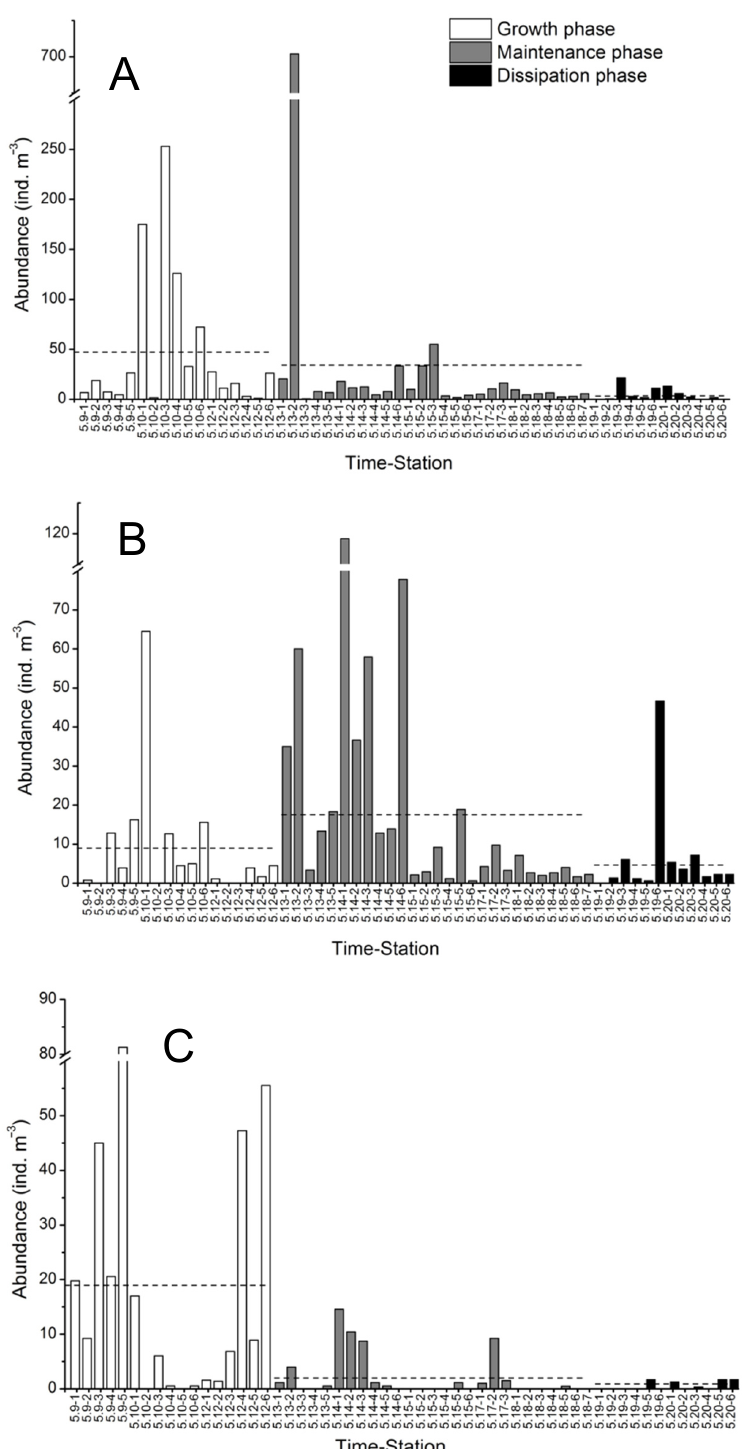
Figure 3. The abundance of small jellyfishes M. atlantica ( A ), chaetognaths Z. nagae ( B ), and copepods C. sinicus ( C ) at each sampling station in different phases of the P. donghaiense bloom (the dash represents average value).